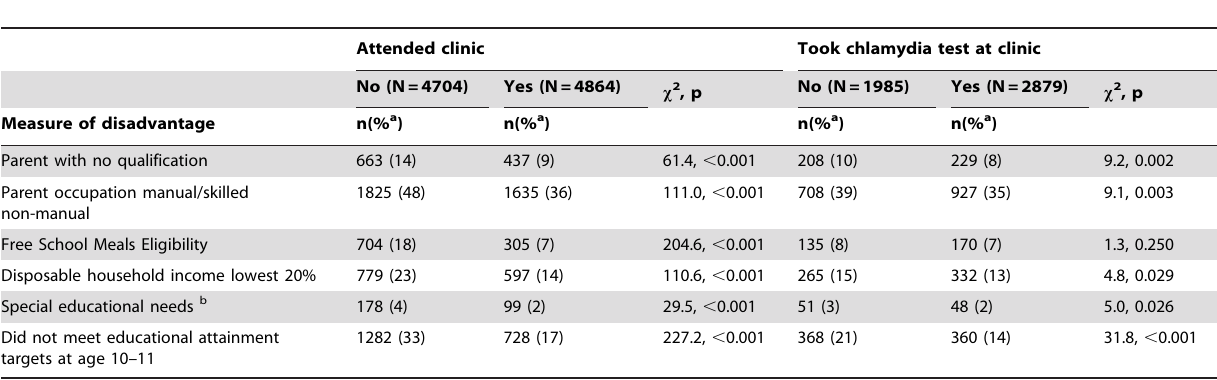
Table 2. Measures of socioeconomic and educational disadvantage, comparing i) participants who did and did not attend the research clinic and ii) clinic attendees who did and did not take the chlamydia